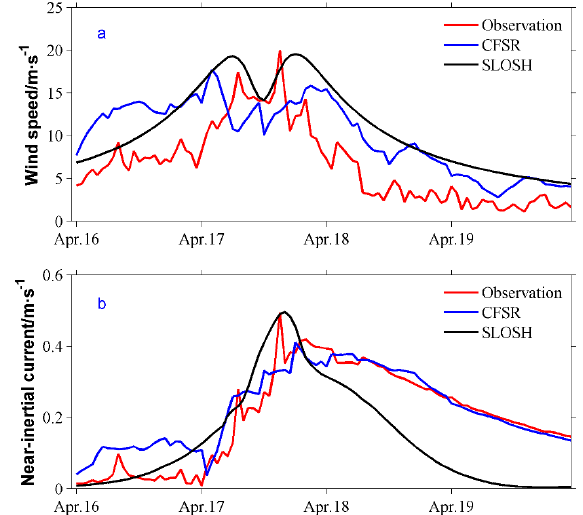
Figure 8. Comparison of ( a ) observed wind speed (unit in m / s, red line), CFSR wind speed (blue line), and idealized surface wind speed by SLOSH model (black line) when Typhoon Neoguri passed by the Xisha observation station from April 16 to April 19. ( b ) Same as in (a), but for the corresponding mixed layer near ‐ inertial currents (unit in m/s).